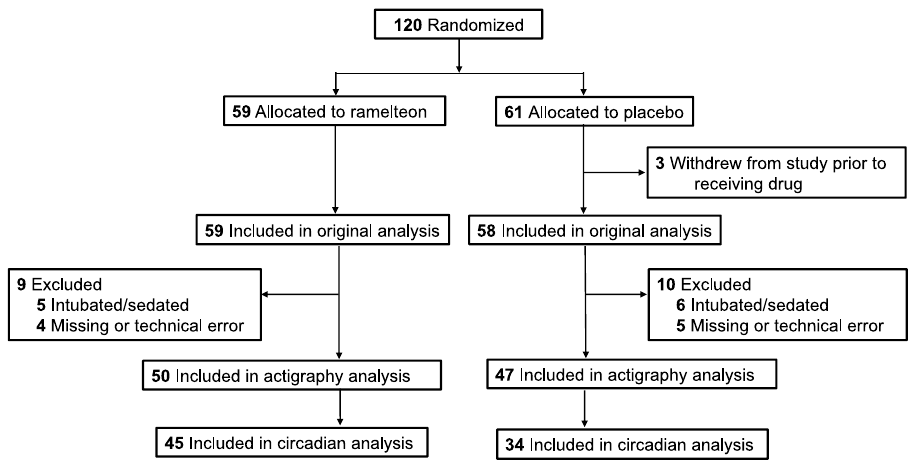
Figure 1. Participant flow diagram. 120 participants were randomized as part of the original clinical trial. There were 97 patients include in the actigraphy analysis presented